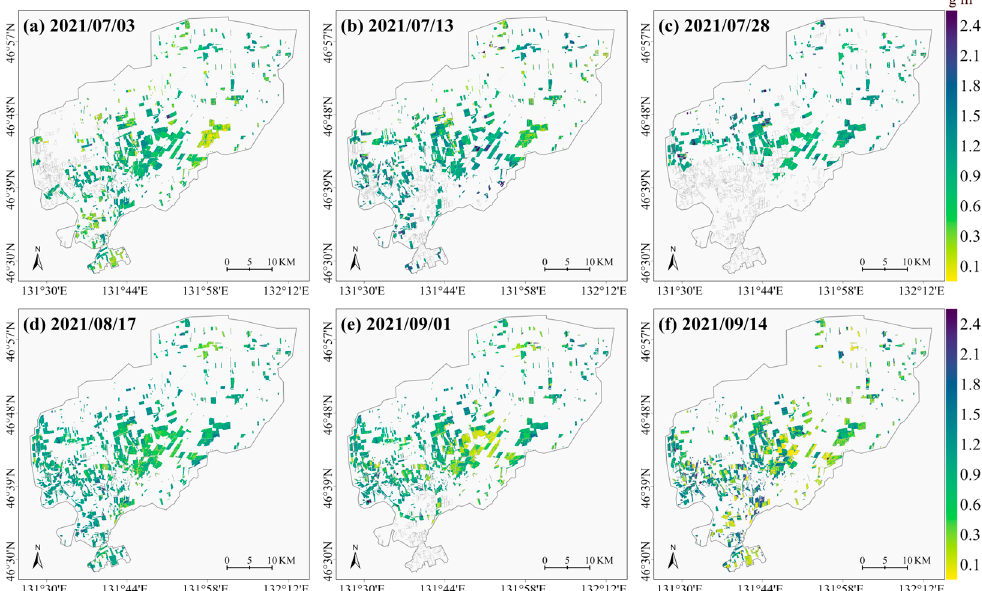
Figure 8. Maize CCC maps of Youyi farm obtained from Sentinel-2 imagery on ( a ) 3 July, ( b ) 13 July, ( c ) 28 July, ( d ) 17 August, ( e ) 1 September and ( f ) 14 September 2021 using the hybrid model.